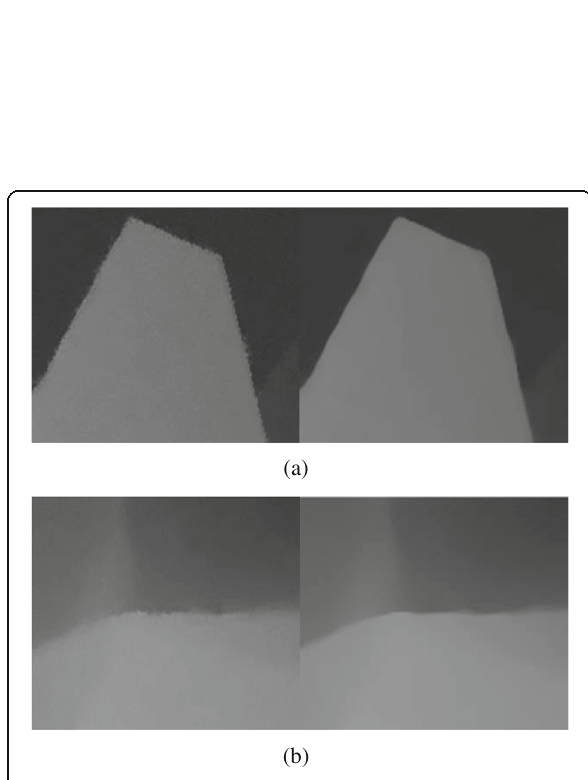
Fig. 9 Two selected regions obtained by the AMF ( left side ) and by the AMF coupled with the RGR ( right side ): a Art and b Doily